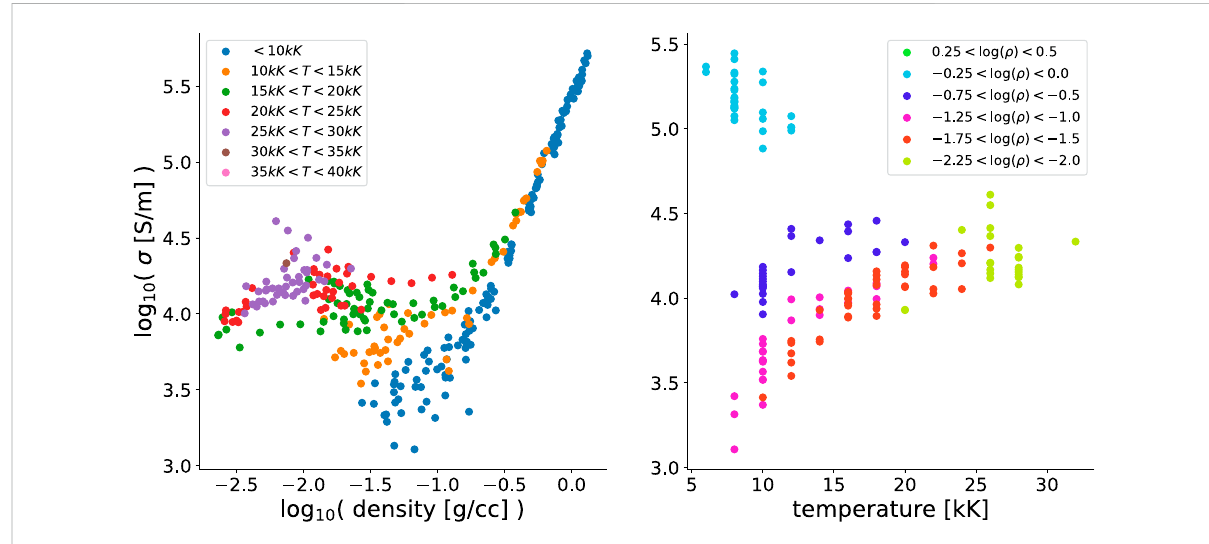
FIGURE 5 Clérouin et al. electrical resistivity data for all elements, shown as histograms and scatter plots. In contrast to the DK data, the densities are constant within a given experiment and resistivities are shown.